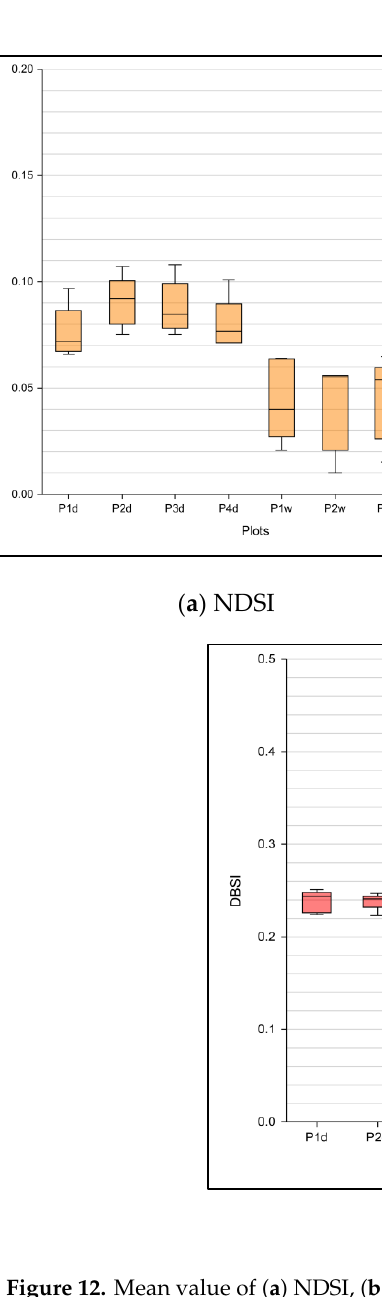
Figure 12. Mean value of ( a ) NDSI, ( b ) RNDSI and ( c ) DBSI of four plots in the study area during the dry and wet season. P1d, P2d, P3d and P4d are four PV parks in the dry season and P1w, P2w, P3w and P4w in the wet season .